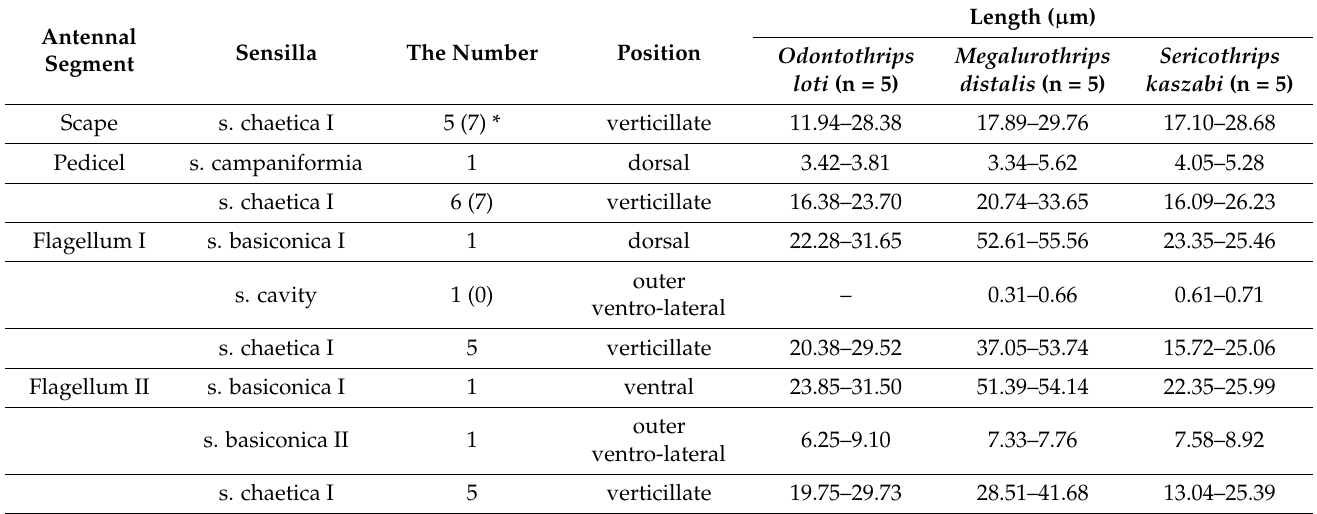
Table 2. The number, location, and length of antennal sensilla in three thrip